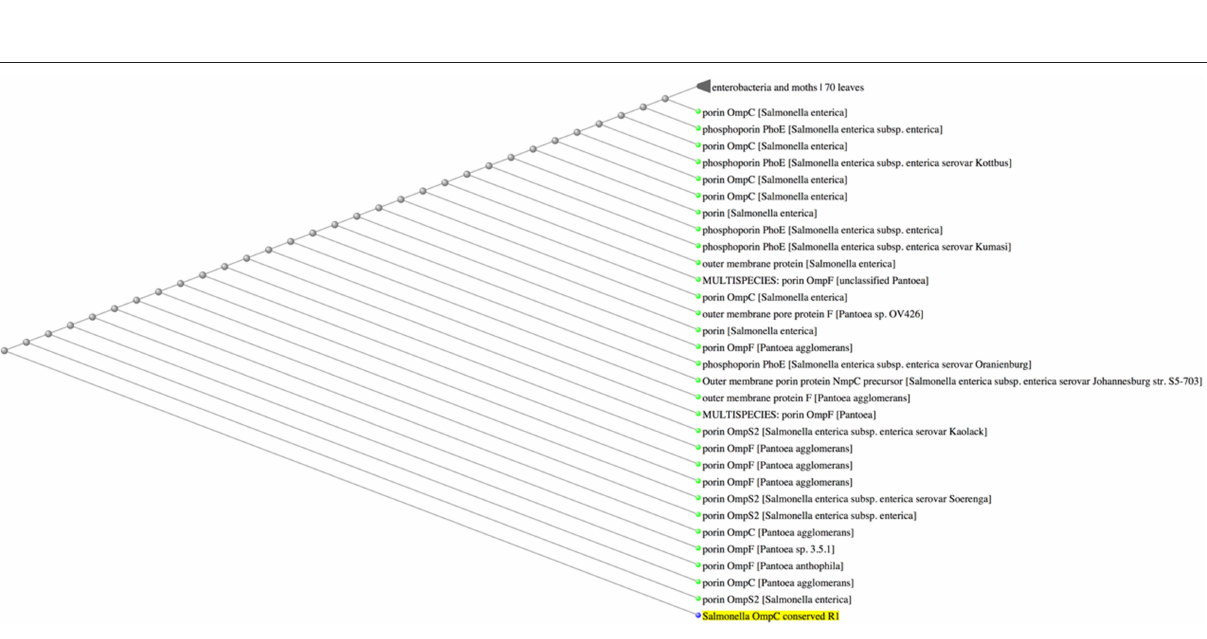
Frontiers in Immunology | www.frontiersin.org